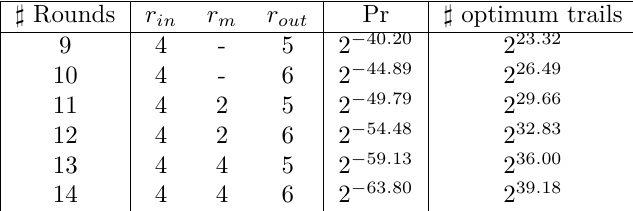
Table 7: The values of r in , r m , and r out of the best differential trails of CRAFT that we have found. Pr denotes the probability of the related